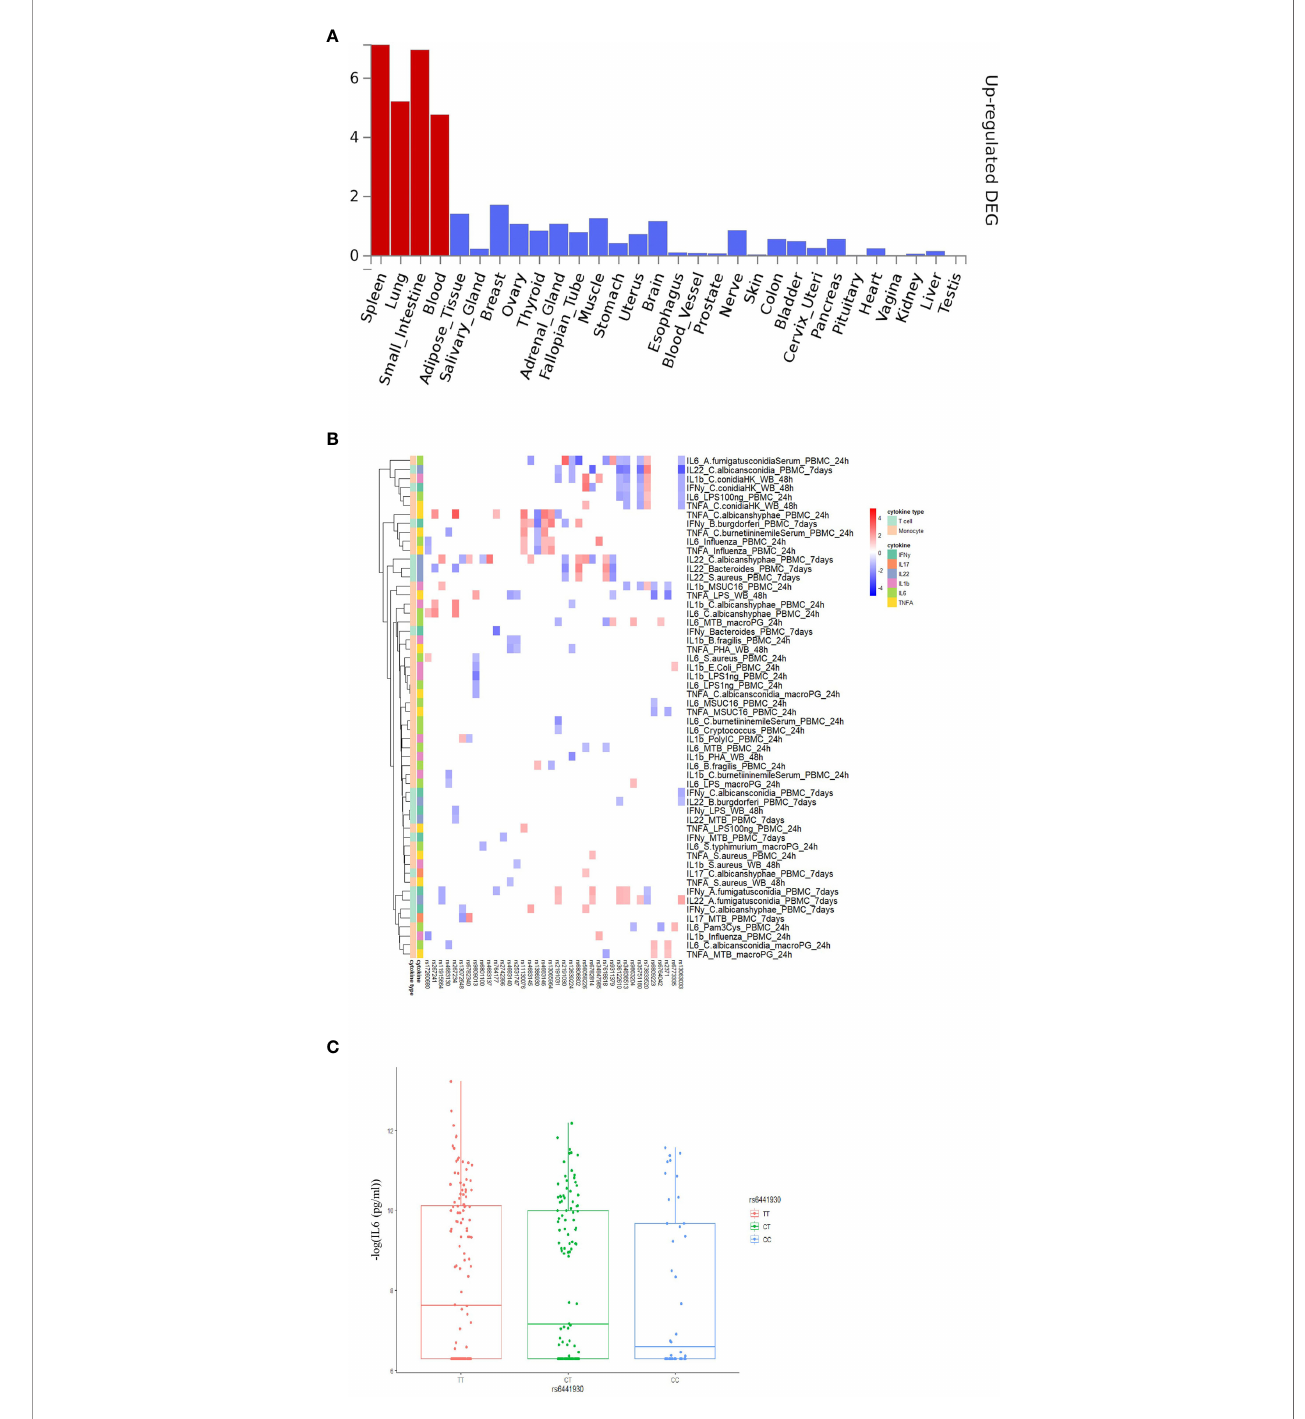
FIGURE 2 | Functional annotation of COVID-19 loci from Severe COVID-19 GWAS study using the FUMA pipeline and association 3p21.31 loci with immune traits. (A) MAGMA Tissue expression results on 30 general tissues type (GTEx v8). FUMA analysis was done based on genes identi fi ed after using their genomic location, eQTL associations, and histone activity. Signi fi cant tissues are shown in red. (B) The heatmaps showing the 250kb window of independent association between 3p21.31 loci with cytokine production upon in vitro stimulations. Red color in heatmap indicates higher cytokine production led by risk allele in COVID-19 GWAS pro fi les, Blue color indicates lower cytokine production leaded by risk allele in COVID-19 GWAS pro fi les. (C) a boxplot showing COVID-19 risk allele(rs6441930-C) associated with reduced IL6 production with in fl uenza stimulation of PBMC for 24 hours (p-value =